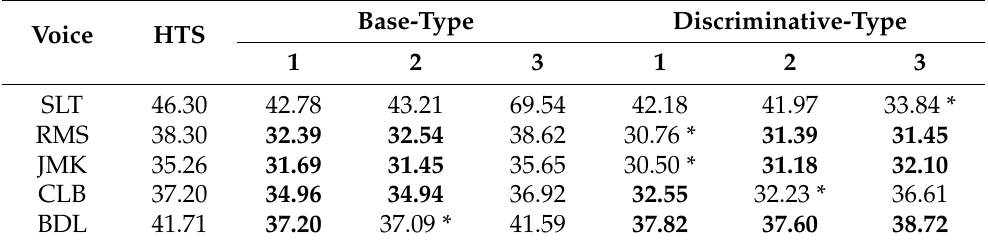
Table 2. WSS Results for the hierarchical clustering levels. The lower values represent better results. * indicates the best result. In bold are the results which are not significantly different from the best, according to Tukey’s HSD test.